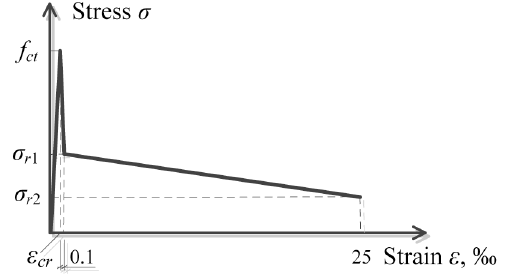
Fig. 2. Stress-strain relationship proposed in RILEM